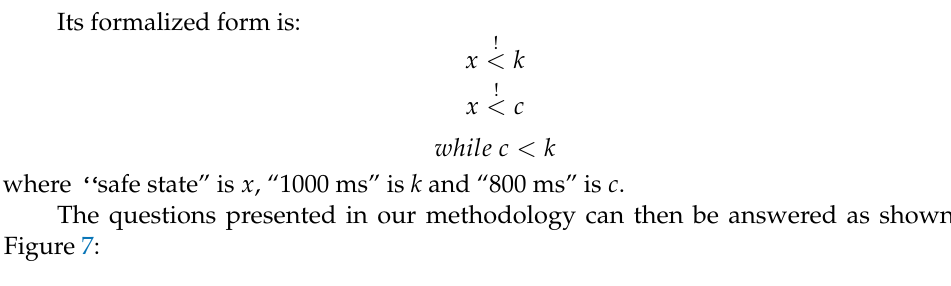
Figure 7. Process for Simplex Subaltern. The questions were answered as given in the column for Simplex Subaltern contra- dictions. The last two cause-questions did not need to be answered, because the Simplex- contradictions do not have causes. 5.2.2. Alius Subaltern The two selected requirements are: